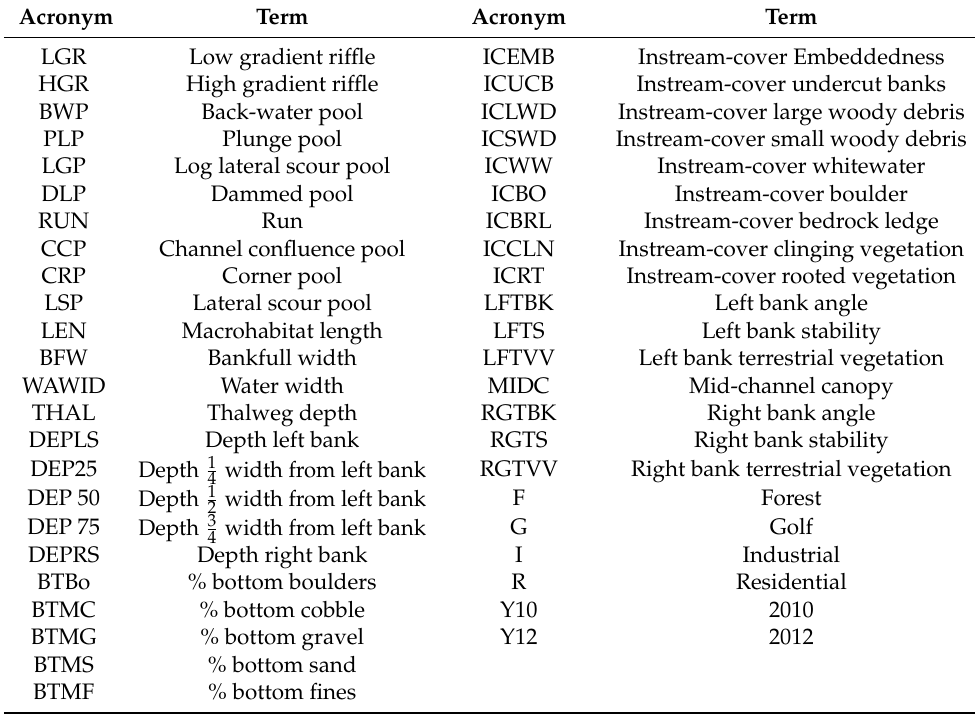
Table A1. Acronym term definitions for the 33 Basin Area Stream Survey